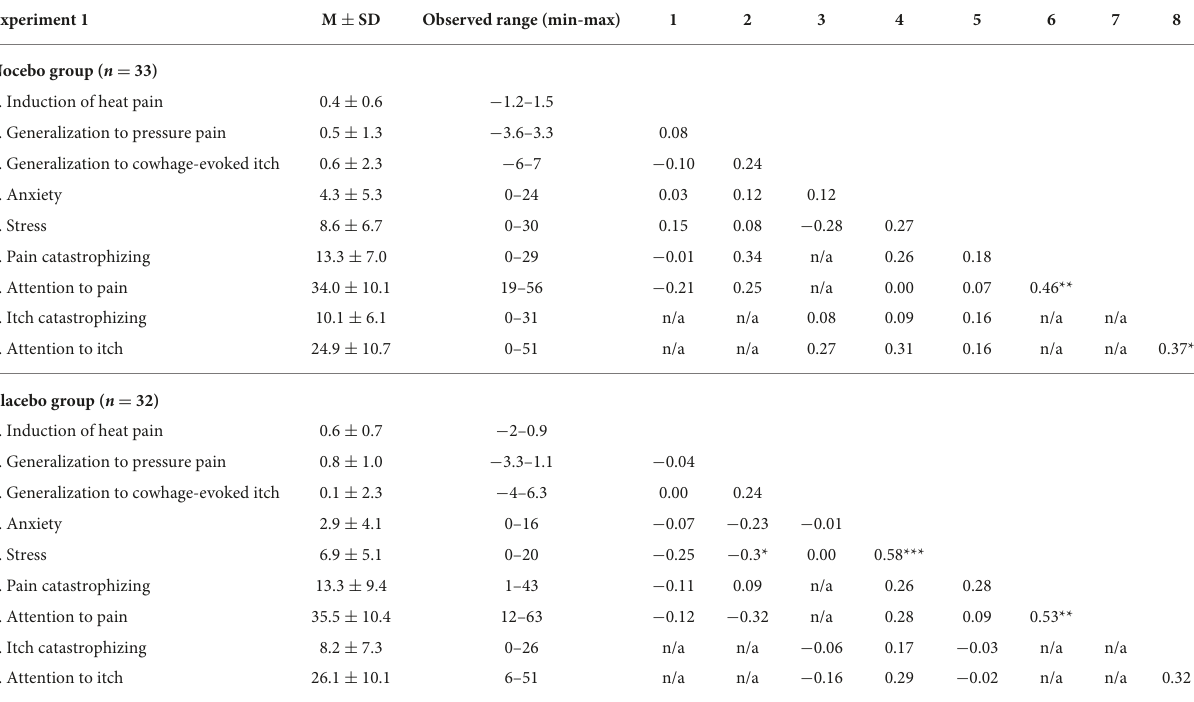
TABLE 1 Mean ± SD and intercorrelations of predictors and dependent outcomes in the nocebo and the placebo group in experiment 1. Experiment 1 M ± SD Observed range (min-max)